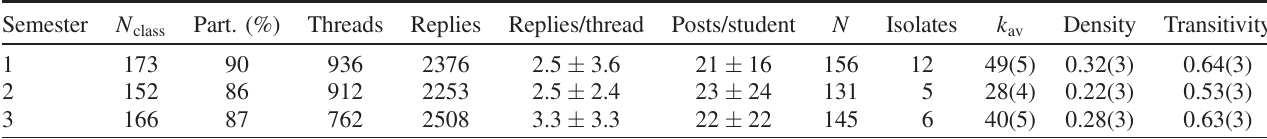
TABLE I. Forum participation and network statistics by semester. Participation includes students enrolled ( N in the forum, total number of threads and replies, and average replies per thread and posts per student plus or minus standard deviation. Network statistics include number of nodes ( N ), isolates, average degree k measures, numbers in parentheses indicate the standard error in the last digit.